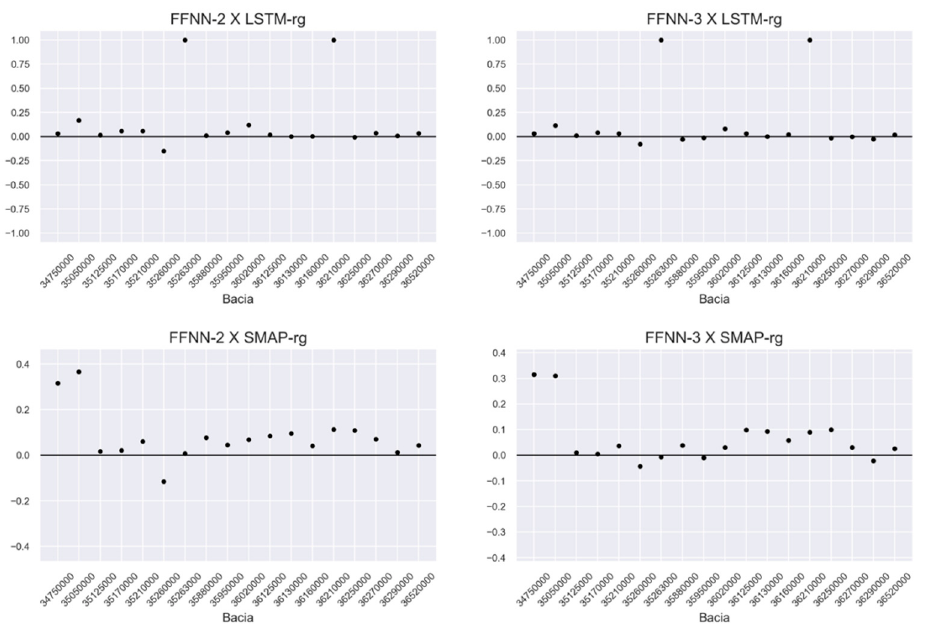
Figure 9. The y-axis represents the logarithm of the ratio of the NSE index of the FFNN-2 and FFNN-3 over the NSE index from the LSTM-rg and SMAP for all basins in the subset “iii” (x-axis).